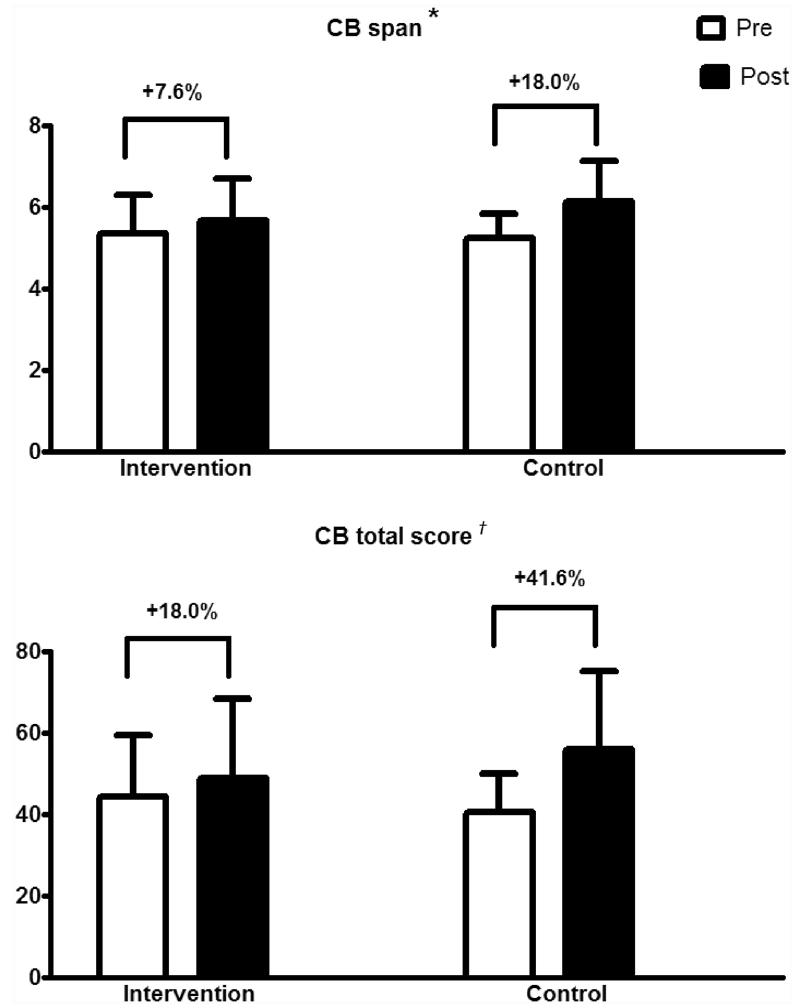
Figure 1. Corsi block-tapping test results (span and total score) pre and post 16 weeks. Data are expressed by the mean and standard deviation. Note : * p < 0.001 for time. † p = 0.039 for time versus group